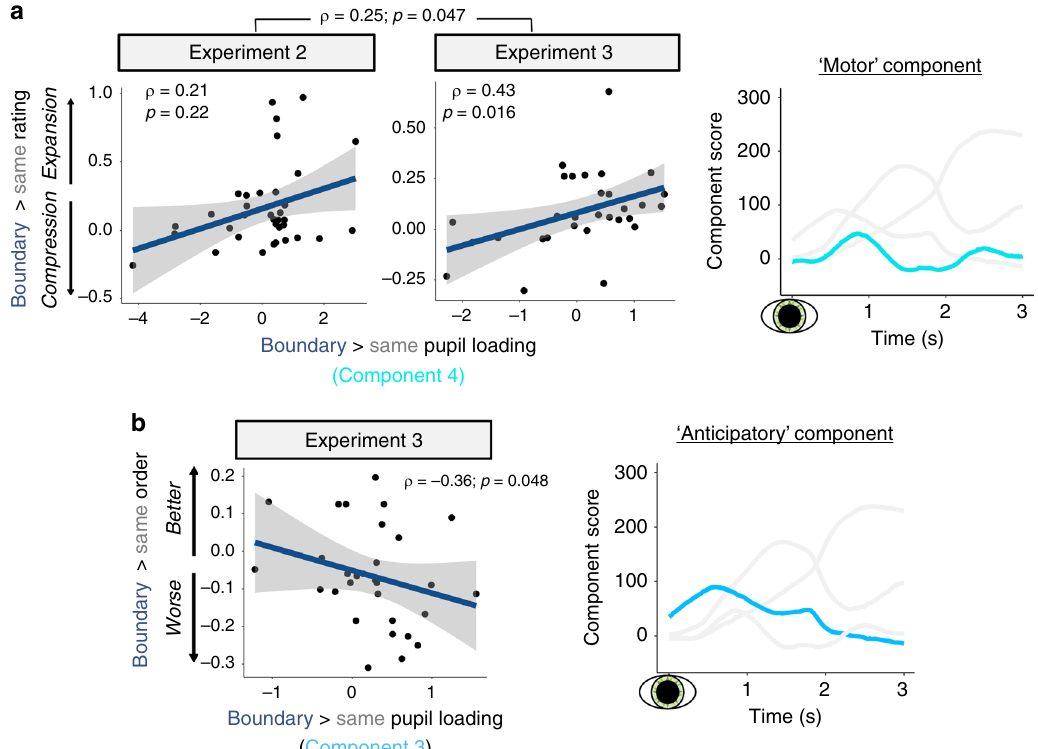
Fig. 7 Different temporal characteristics of boundary-triggered pupil dilation relate to subjective and objective aspects of temporal memory. a Association between boundary-modulated loadings on the early-peaking pupil component (#4; turquoise) and boundary-related effects on retrospective estimates of temporal distance between item pairs. Higher values on the y -axis re fl ect more expanded estimates of average temporal distance for boundary-spanning pairs compared to same-context pairs. This pupil – memory relationship was signi fi cant across both eye-tracking studies (Experiments 2 and 3) and signi fi cant in Experiment 3 alone. b Association between boundary-modulated pupil loadings on the slowly decreasing pupil component (#3; sky blue) and boundary-related effects on temporal order memory between item pairs in Experiment 3. Lower values on the y -axis re fl ect worse average temporal order memory for boundary-spanning item pairs compared to same-context pairs. Gray shading in all three regression plots represents 95% con fi dence interval. Overlaid black dots represent individual participants (Experiment 2: n = 35; Experiment 3: n = 30). p -values were derived from two- tailed tests, and no corrections were made for multiple comparisons. Source data are provided as a Source Data fi